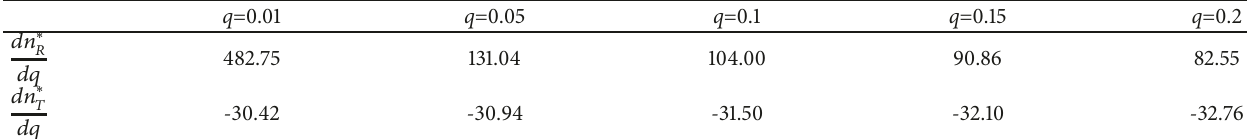
Table 2: Sensitivity analysis of 𝑛 ∗ 𝑅 , 𝑛 ∗ 𝑇 to q .